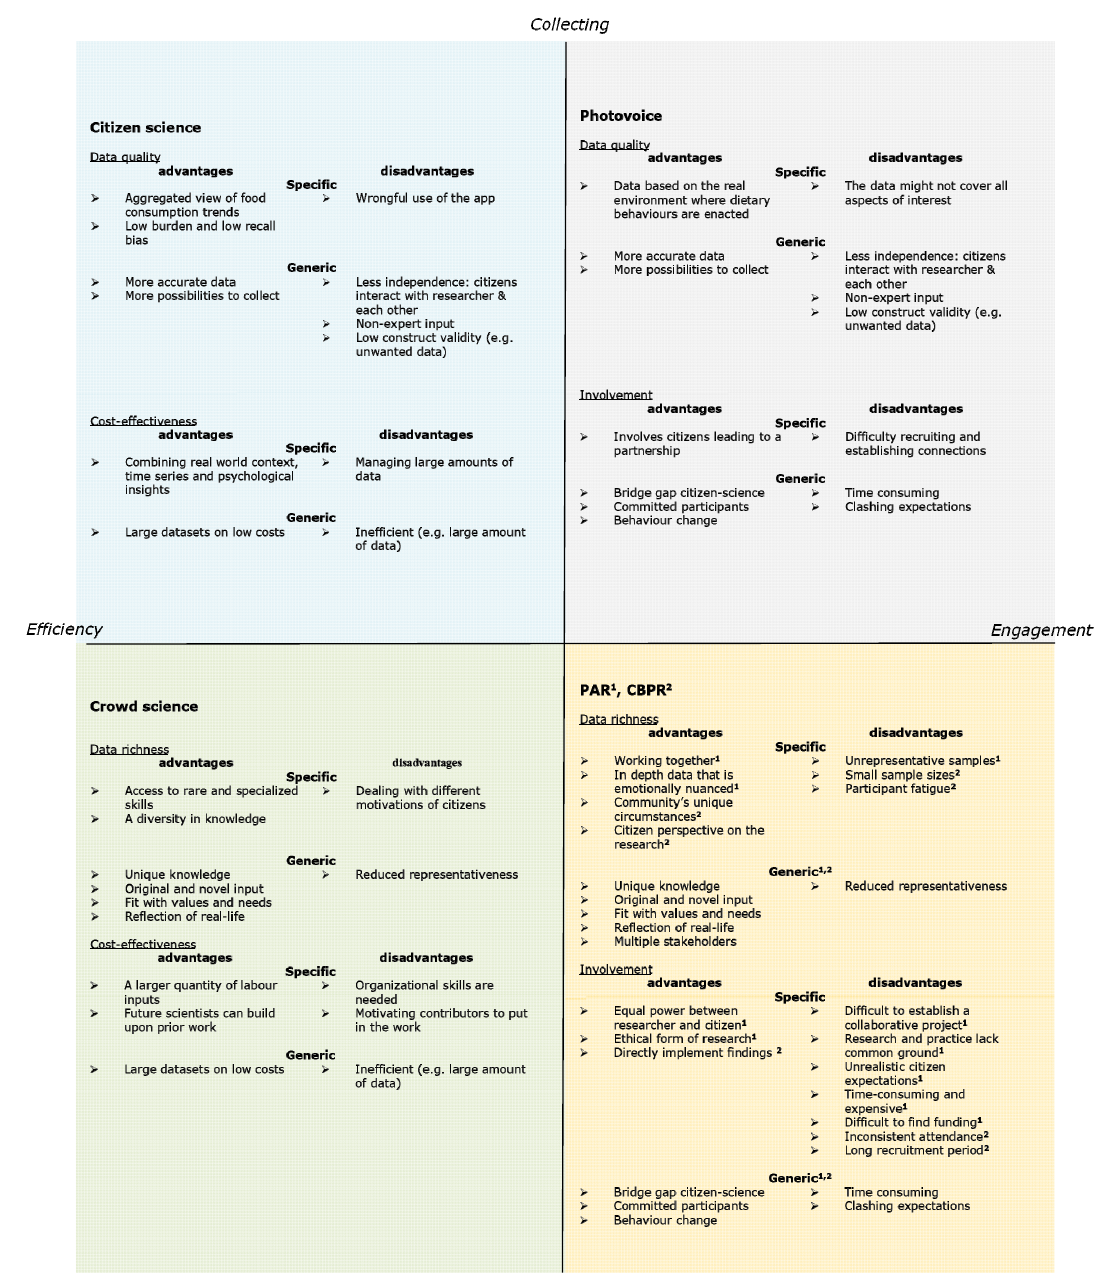
Figure 2. Most substantial advantages and disadvantages per dimension, participation method and area from food